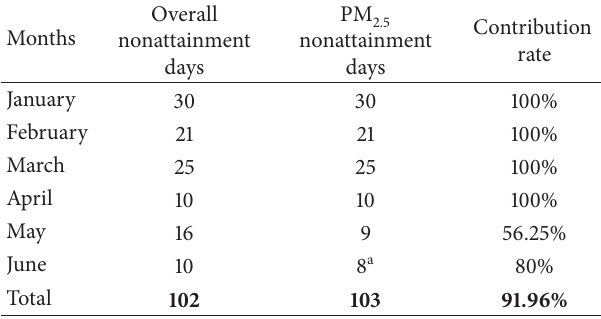
Table 4: Contribution of PM first 6 months of